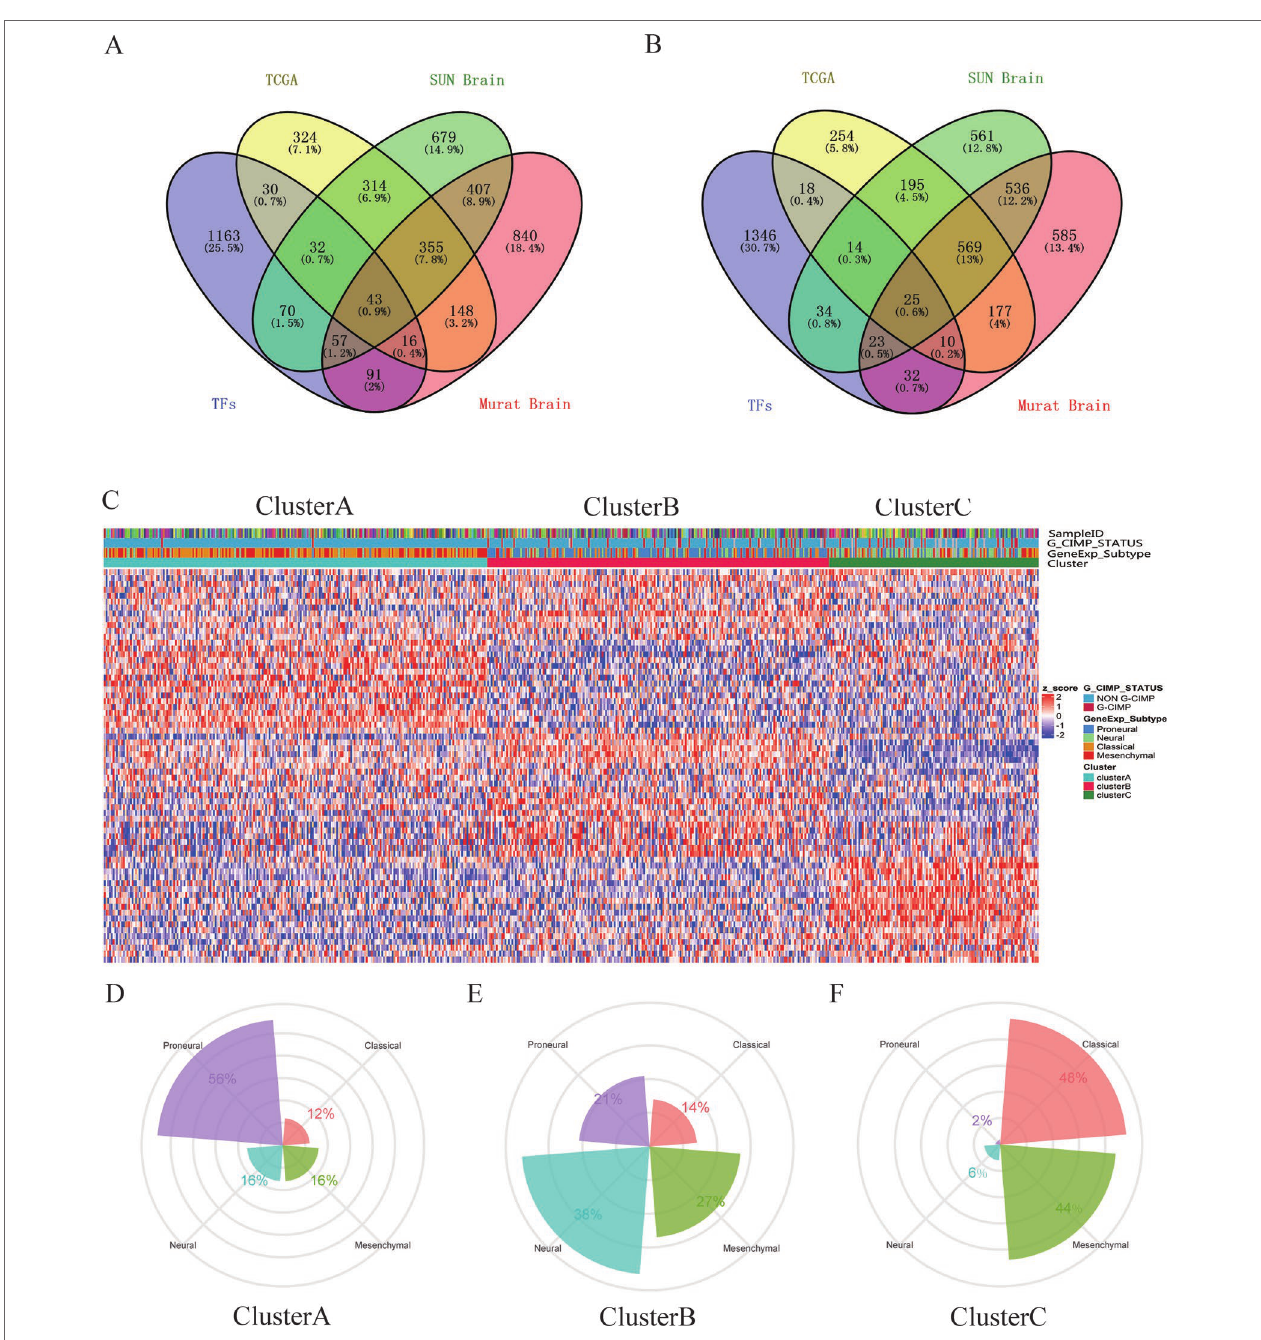
FiGURe 1 | Identification of differentially expressed transcription factors (DETFs). (A) total of 43 significantly upregulated transcription factors were screened from the three databases of The Cancer Genome Atlas (TCGA)/SUN brain/Murat brain. (B) A total of 25 significantly downregulated transcription factors were screened from the three databases of TCGA/SUN brain/Murat brain. (c) Clusters A–C of glioblastoma (GBM) patients through 68 transcription factors using the nonnegative matrix factorization (NMF) clustering method. (D – F) Proportions of proneural, mesenchymal, classical, and neural in Clusters A–C.